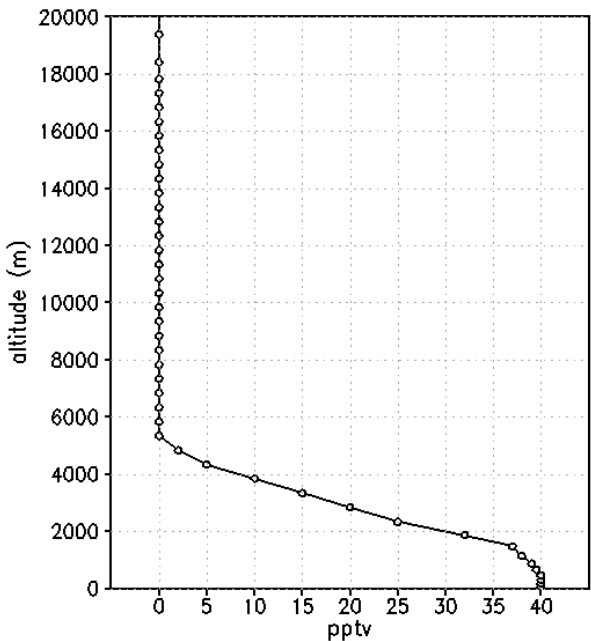
Fig. 1. Initial bromoform profile used in the BG1 and PERT1 sim- ulations. This profile is set homogeneously horizontally over the Figure 1: Initial bromoform profile used in the BG1 and PERT1 simulations. This profile is set whole homogeneously horizontally over the whole domain.